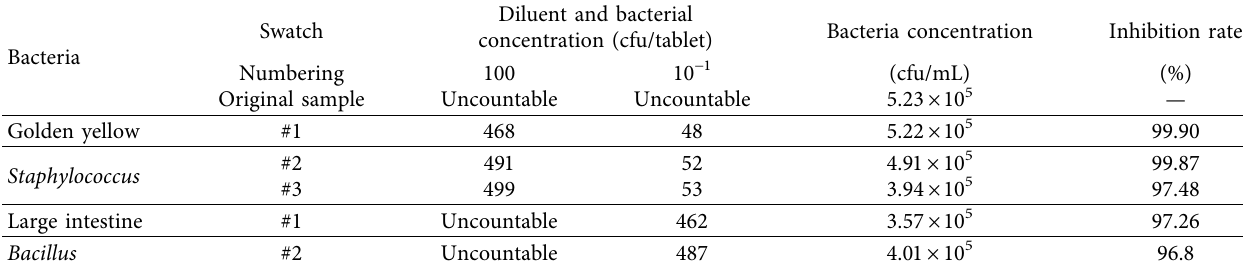
Table 3: Bacteriostasis of fabric after 20 washings.